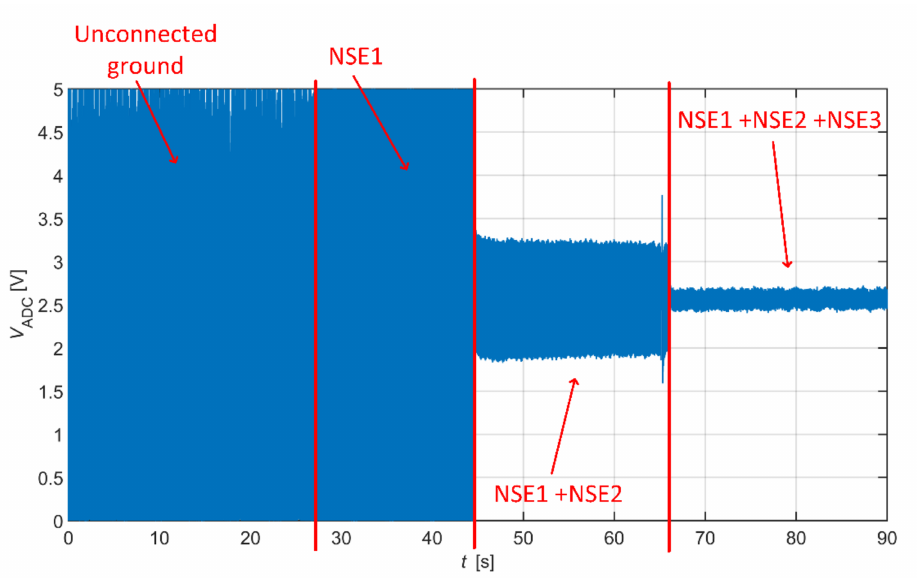
Figure 17. Capacitive ECG with gradually connected grounding